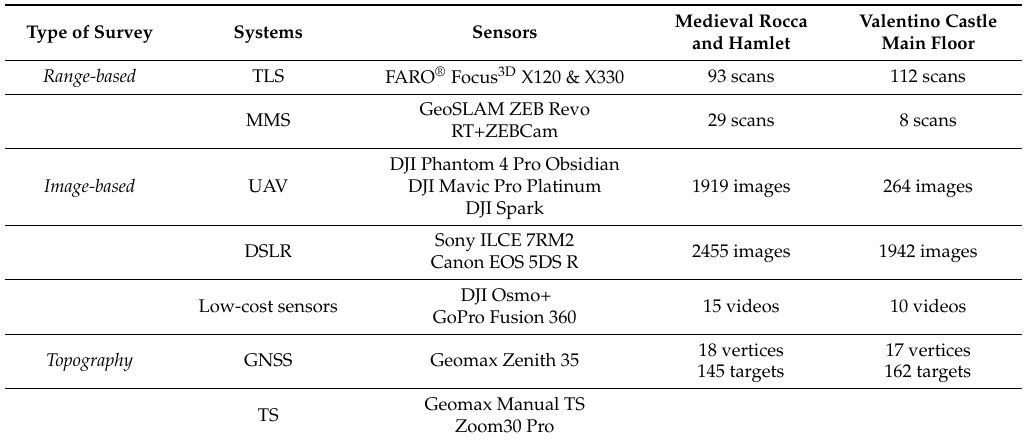
Table 1. Sensors employed in the acquisition phase and general overview of the amount of collected data for the entire